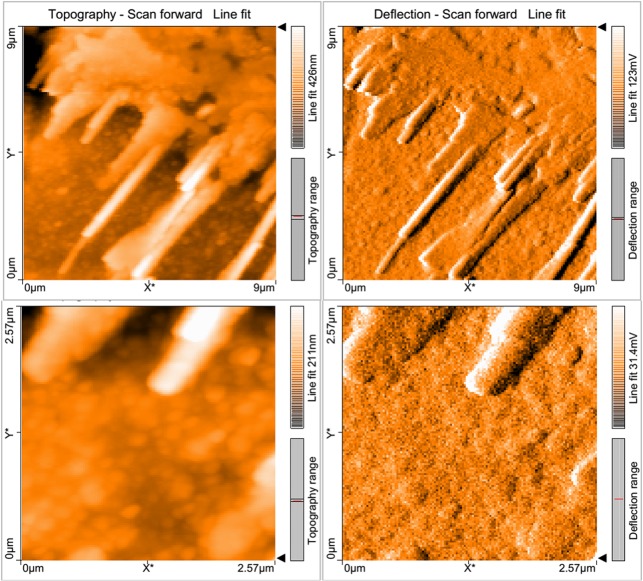
AFM images of MSR2 after biosorption: (a) scanning range 9μm and (b) scanning range 2.5μm.